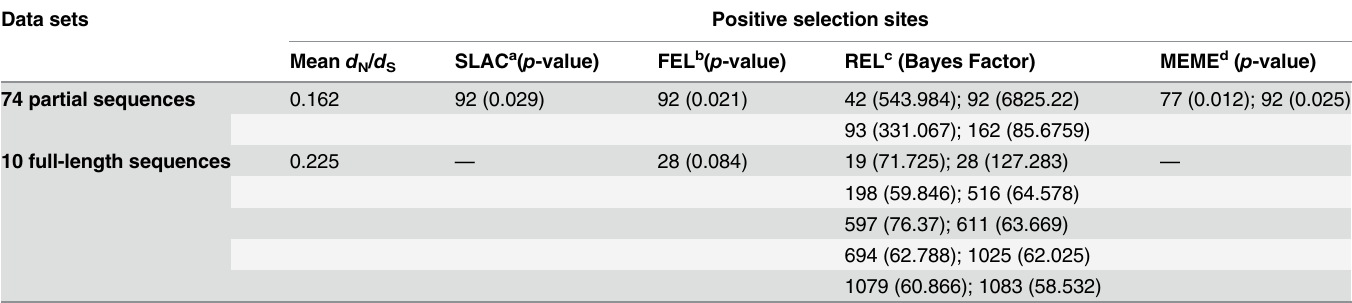
Table 2. Positive selection analysis using SLAC, FEL, REL and MEME methods. Data sets